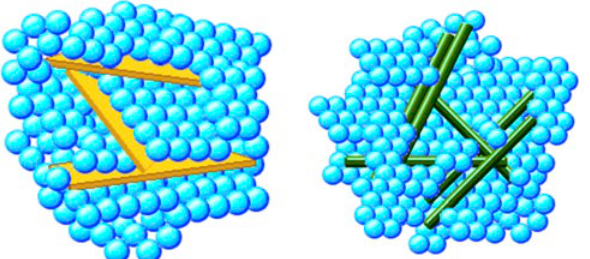
Figure 15. Accretions of silica spheres containing impurities tend to break up in the shear regime during laminar flow (From Elliston 9 , 2017,